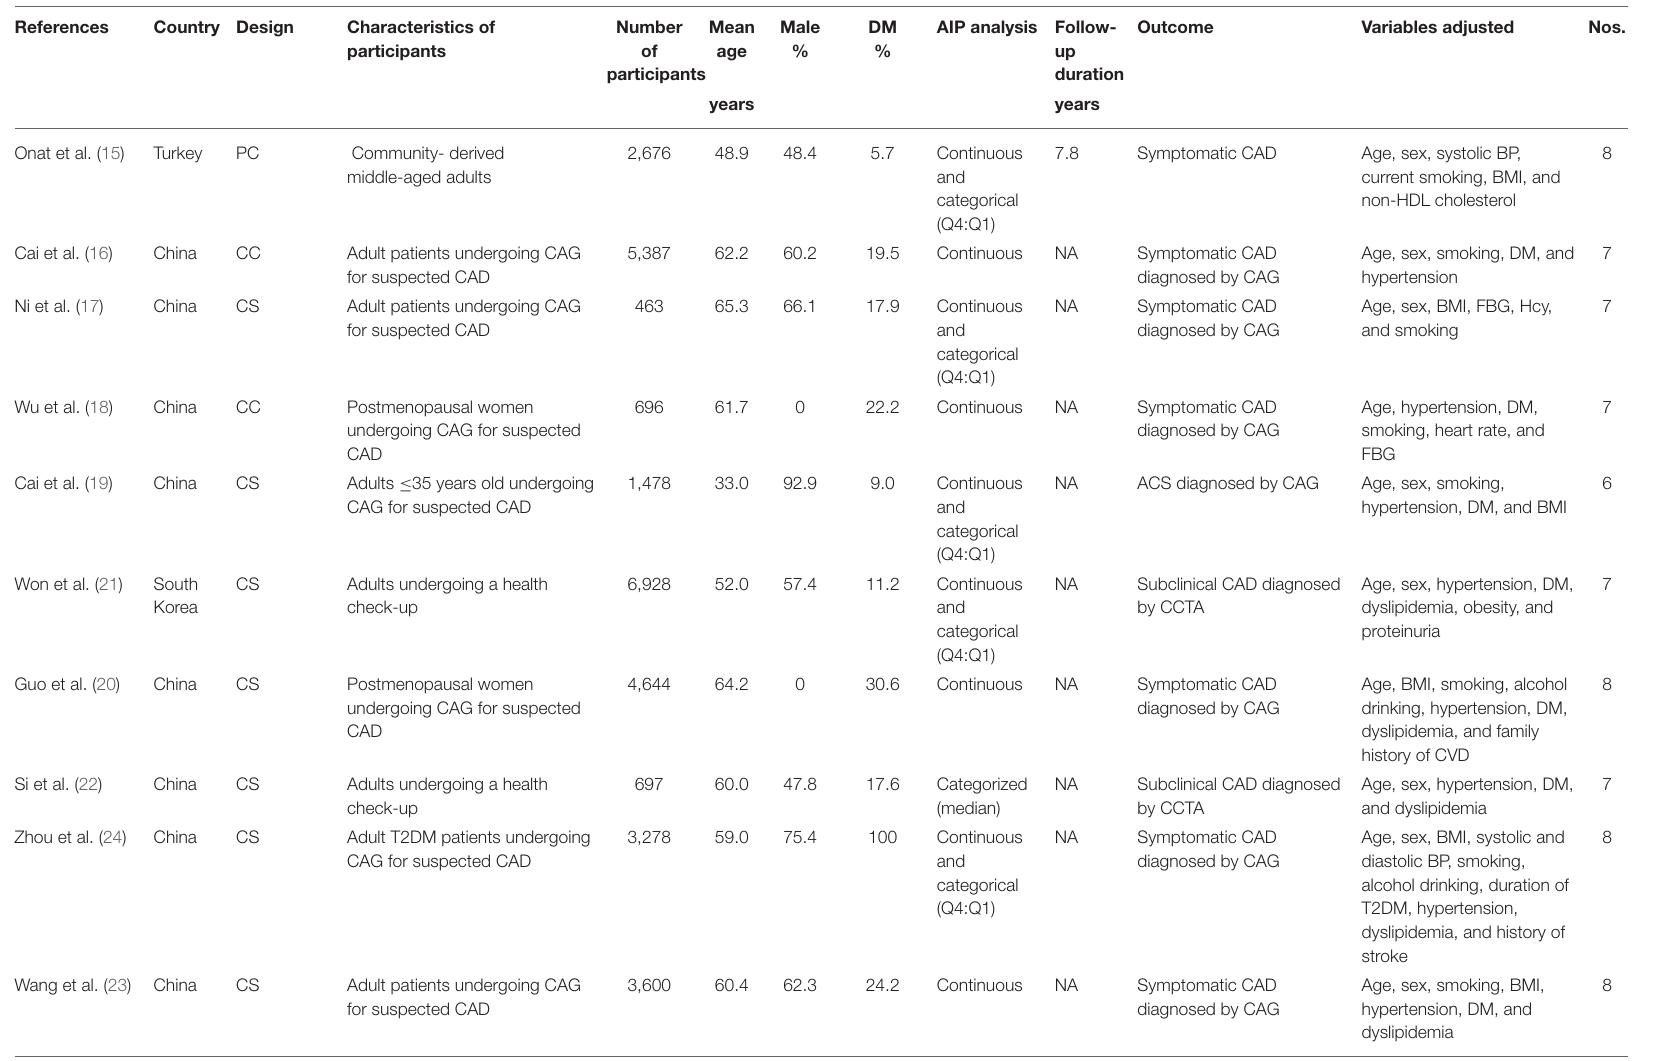
TABLE 1 | Characteristics of the included